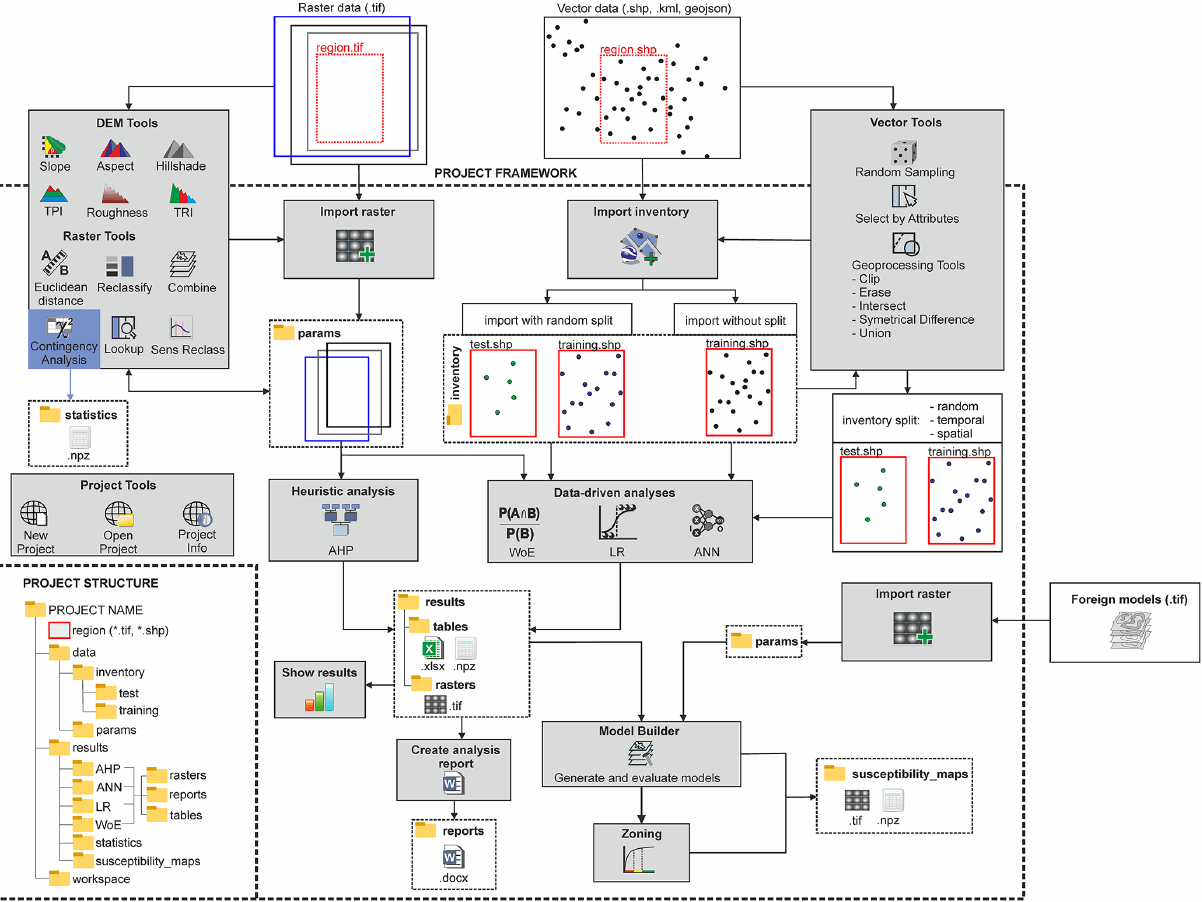
Figure 1. Standardized project structure and the logical workflow of LSAT PM.